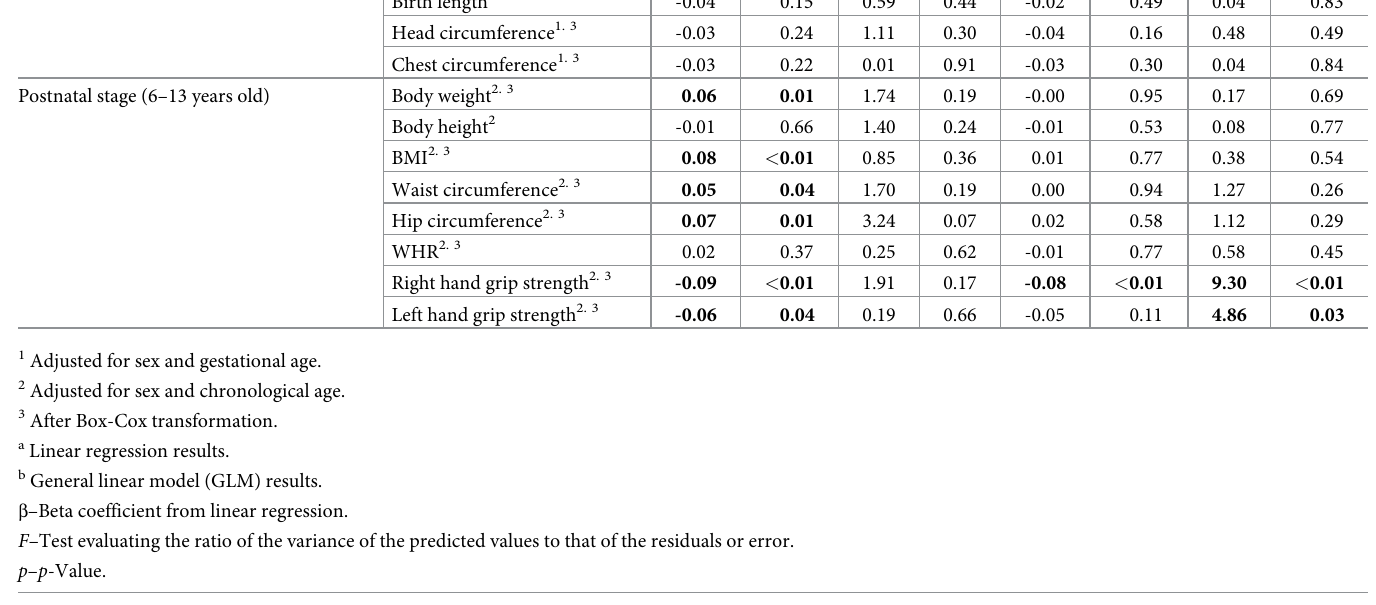
expected for their sex and chronological age). The results were not statistically significant either for boys or girls separately, or for the entire group taken together (Table 6). All interactions between variables are presented in Fig 5 (blue arrows). Additionally, a catch-up growth event is shown in the background (orange arrow).